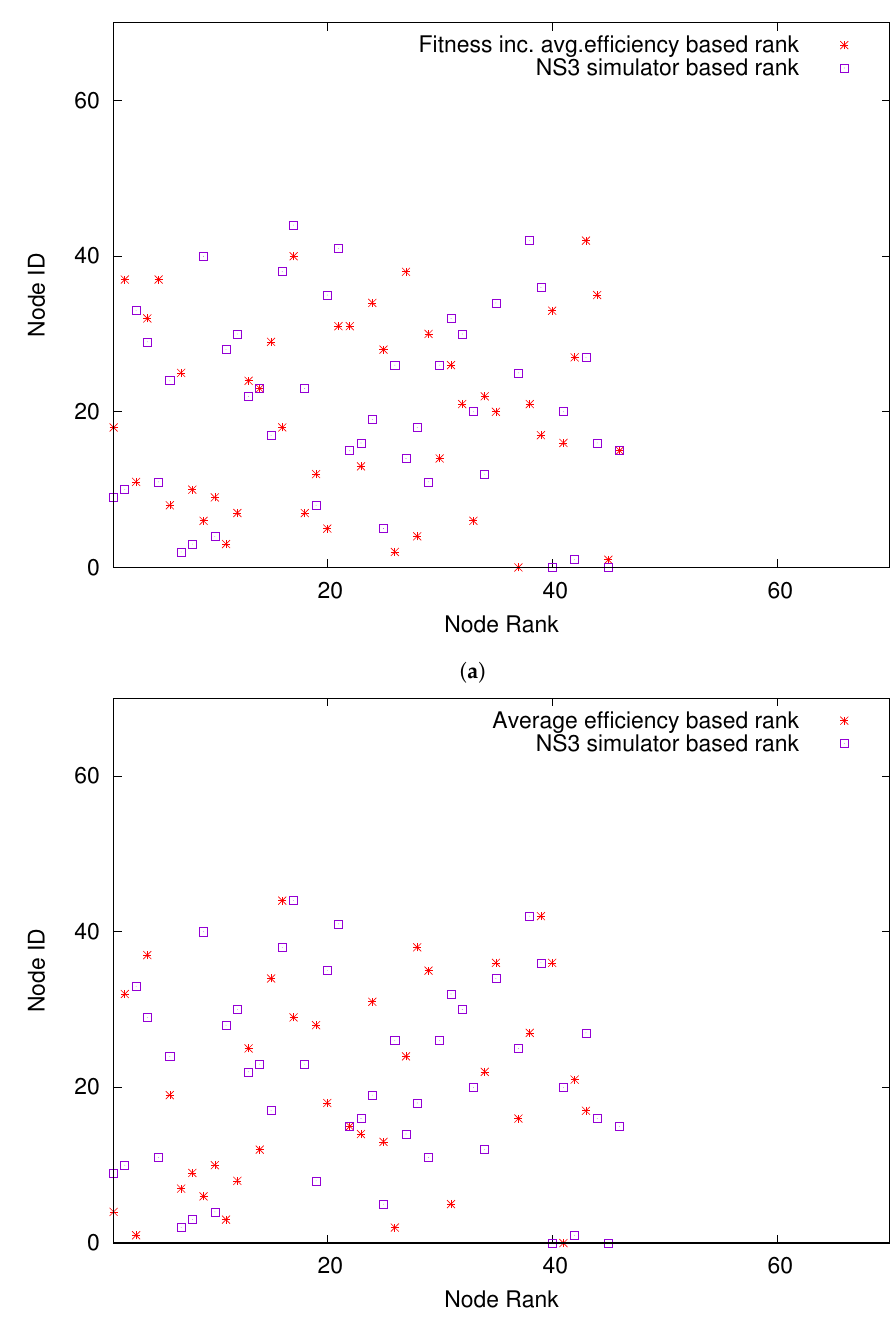
Figure A4. Node ranking comparison for scale-free topology, when the fitness is distributed in a manner that does not correlate with the degree. ( a ) Fitness incorporated average efficiency-based ranking vs. NS3 simulator ranking. ( b ) Average efficiency-based ranking vs. NS3 simulator- based